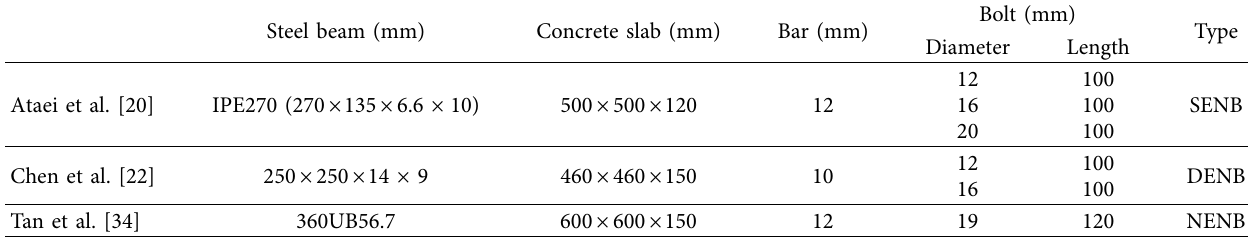
Table 1: Dimensions of the specimens.